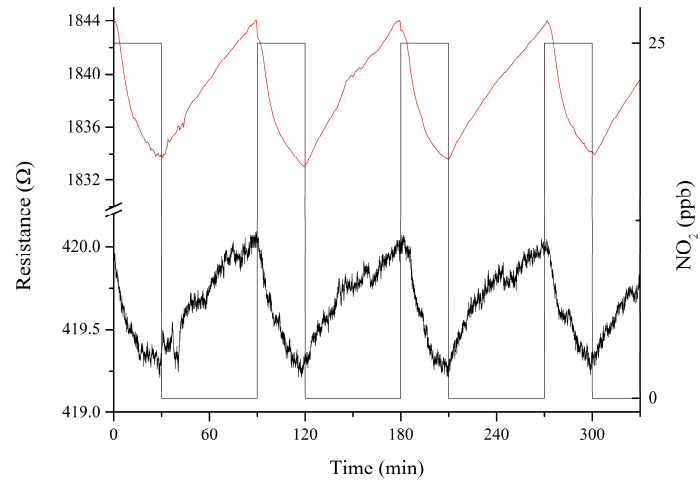
Figure 9. Example of the response for bare carbon nanotubes (black line) and IrO x -MWCNTs (red line) to repeated pulses of nitrogen dioxide at 25 ppb. Sensors were operated at 150 °C. A baseline correction was implemented to suppress baseline drift.